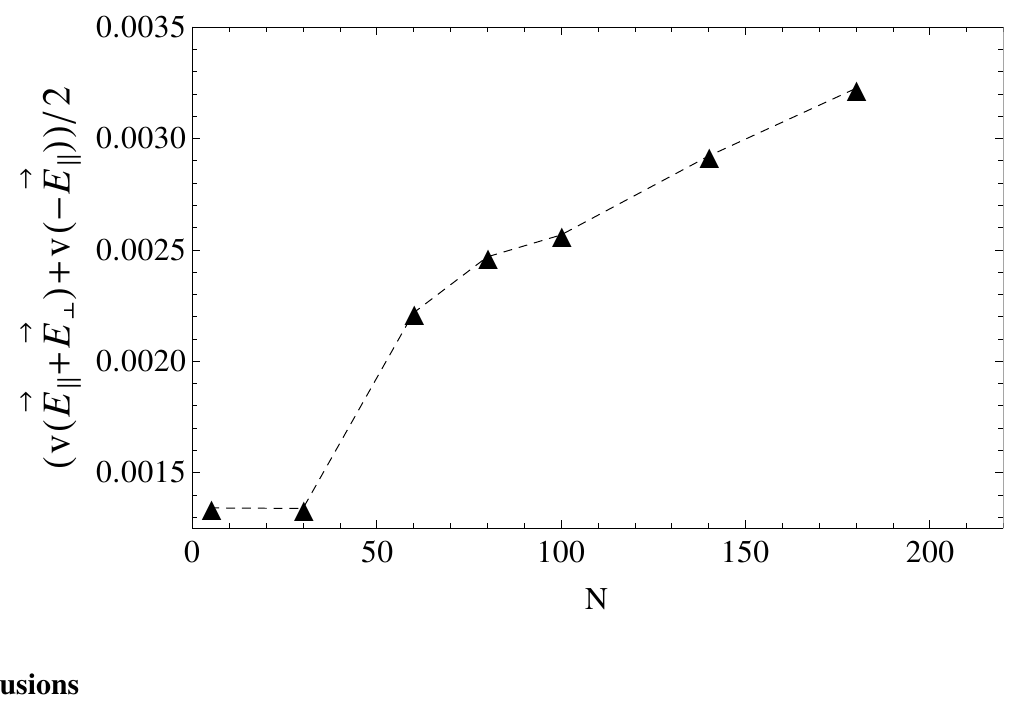
Figure 9. Average electrophoretic velocities as a function of chain length, N , for the case of pulsed transverse fields and pulsed longitudinal fields. During the first half of the pulse, the driving field is ⃗ E ∥ + ⃗ E ⊥ , while in the second half of the pulse, the field is switched to − ⃗ E ∥